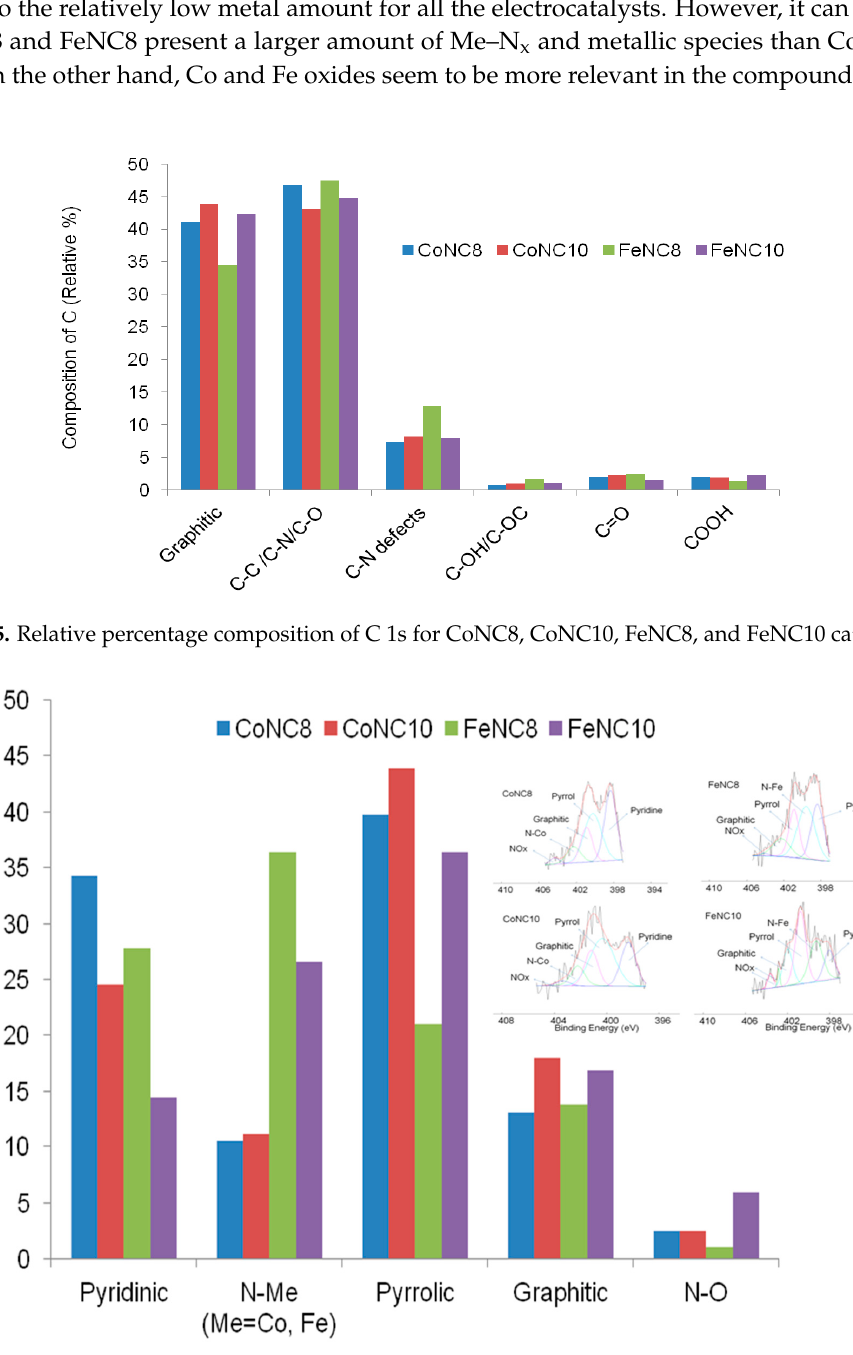
Figure 6. Relative percentage composition and inset of the deconvolution of N 1s XPS signal for CoNC8, CoNC10, FeNC8, and FeNC10 catalysts.